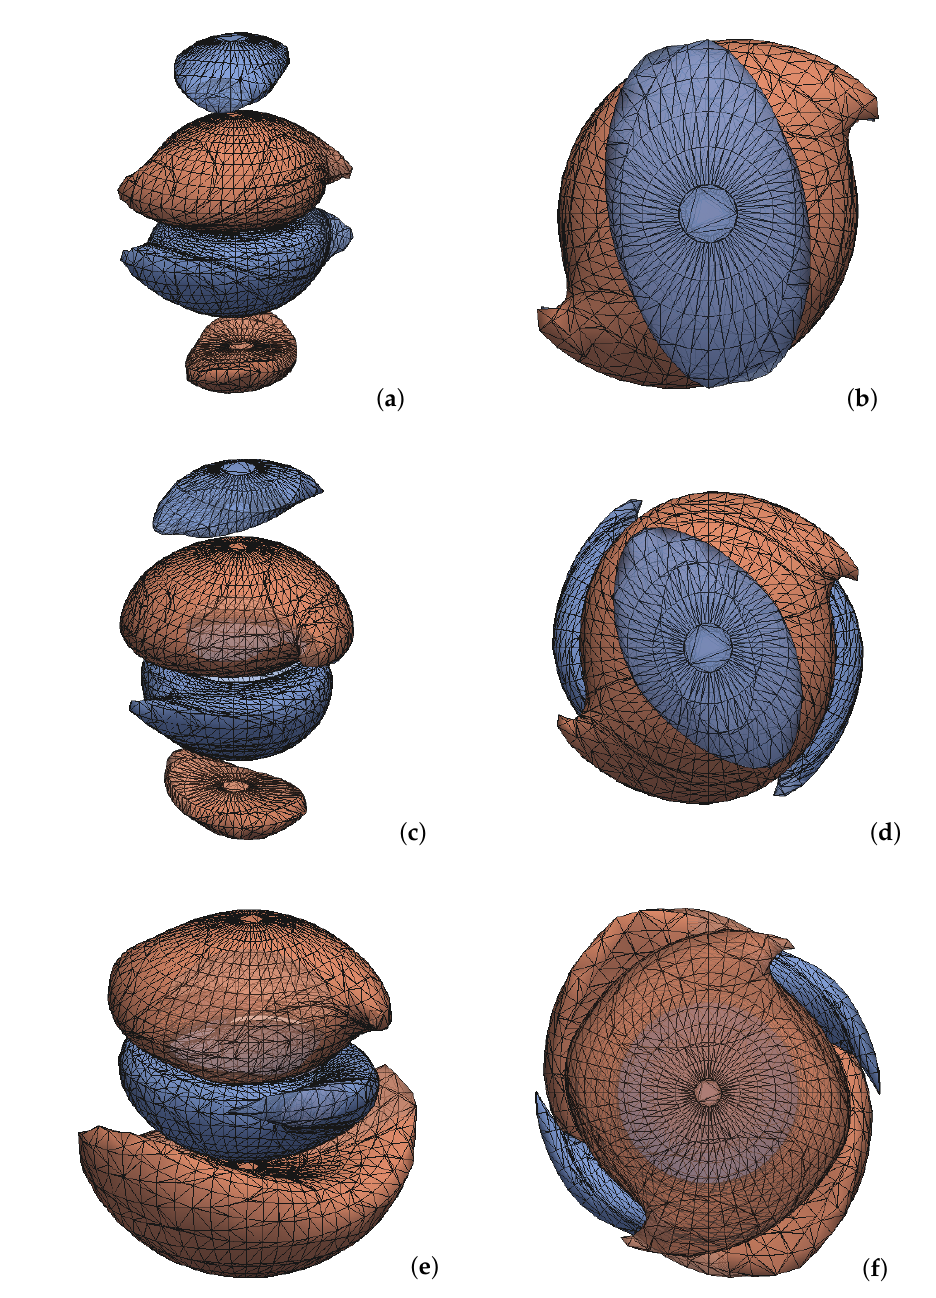
Figure 2. The analytically constructed contours of opposite vorticity (plotted by coding the relevant equations mentioned below into the numerical grid—no actual simulation took place, the data are from direct evaluations of analytical expressions; the reason for doing so is to take advantage of the powerful visualization software Paraview [24], and this approach should not introduce excessive numerical noises since the expressions are smooth and thus pose no challenge to spectral representations). ( a , b ): Two contours of opposite vorticity from the mass quadrupole (Equation (5)) plus a current dipole. The contours, in particular the spiraling arms, are aligned with each other across the orbital plane. ( c , d ): Similar contours from the current quadrupole (Equation (7)) plus the dipole. The contours are misaligned by π /2, and obey skew-reflection antisymmetry. ( e , f ): Both current and mass quadrupoles are included in addition to the dipole. The contours are misaligned by an angle between 0 and π /2, breaking both reflection and skew-reflection antisymmetry. Left column: Side views of the contours (not at the same angle). Right column: Top views (looking down J tot ) of the